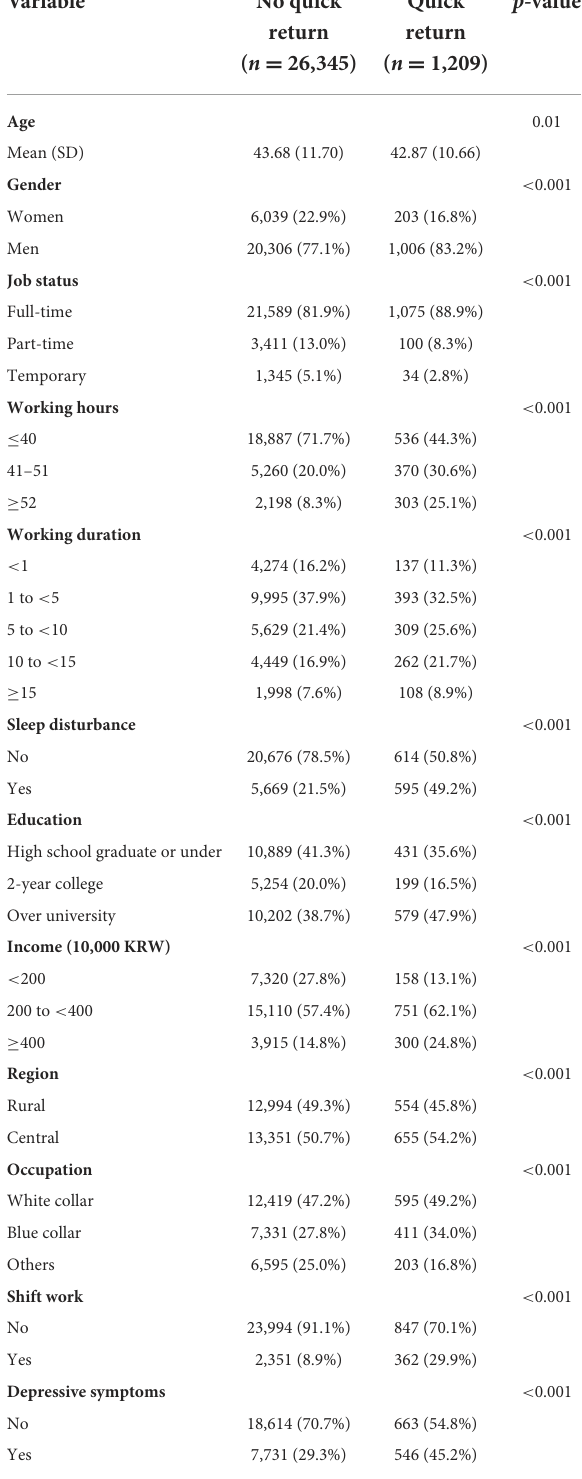
TABLE 1 Baseline characteristics of the participants ( n = 27,554) in 6 th KWCS (2020) stratified by quick return.